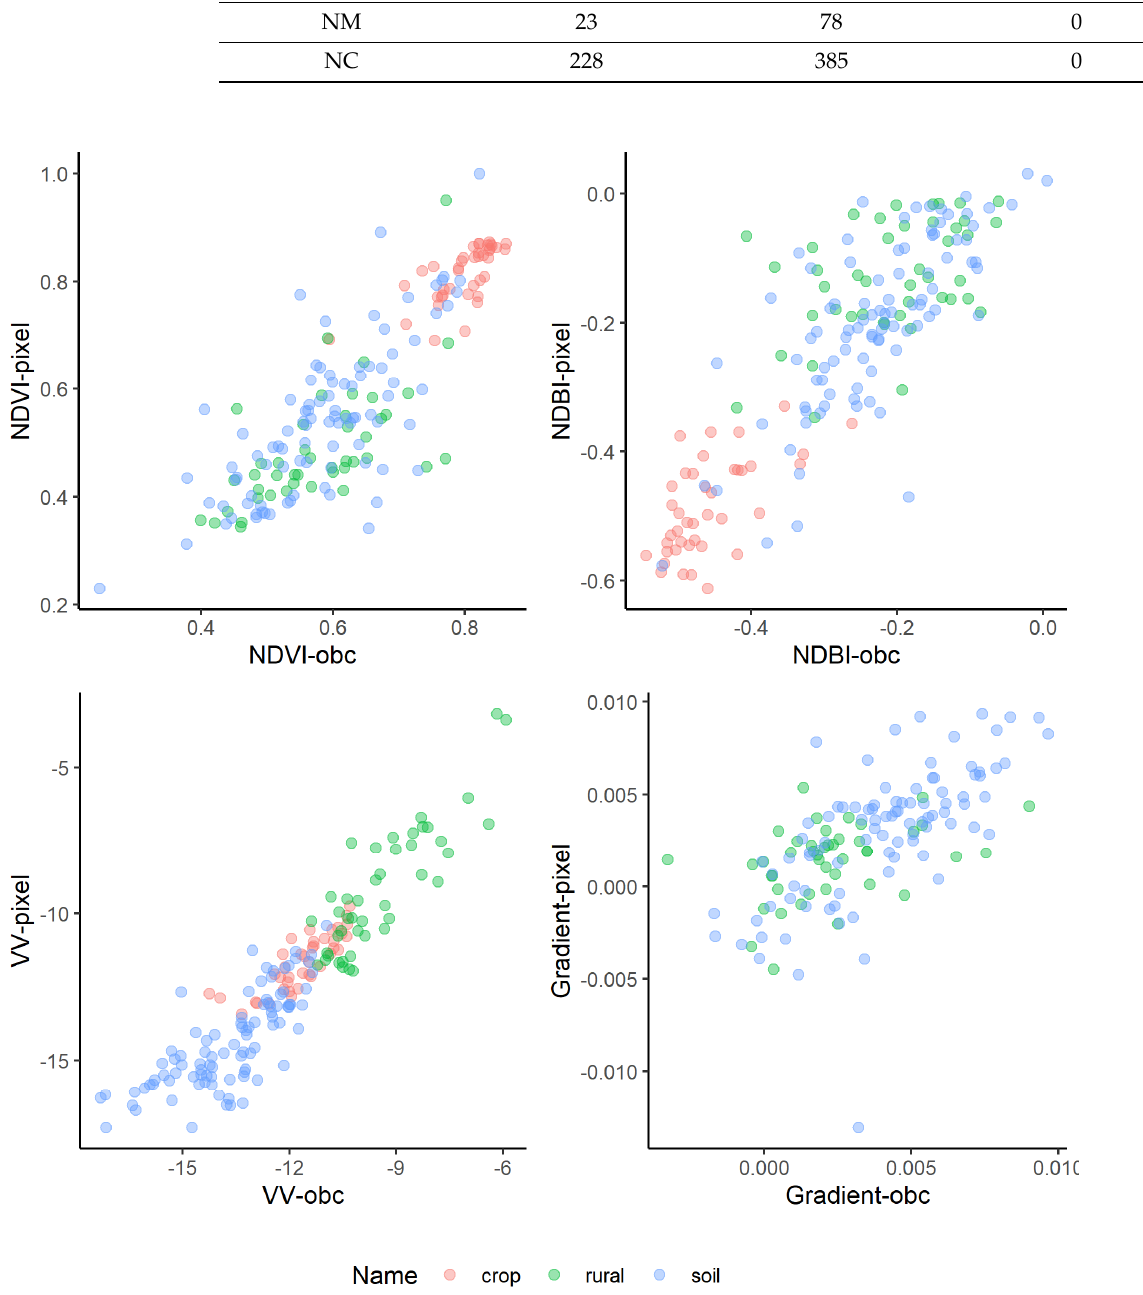
central tendency of small samples. The stat_ellipse method in R language was utilized to circle their distribution with 95% confidence of all the samples (ellipse in Figure 7). We can see that the ellipse captures the most representative land cover samples with the outliers removed. Here, we selected the location of the ellipse boundary (red solid dot) as the threshold to discriminate rural settlements from photosynthetic materials. The red point is from the right end point of the major axis of the ellipse. For other features (NDBI,